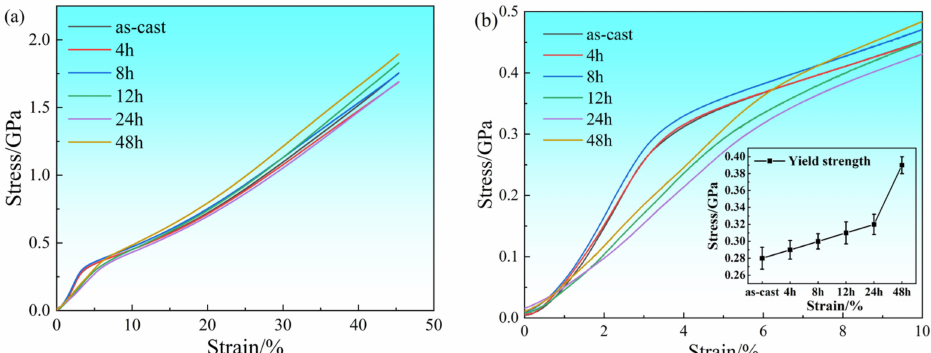
Figure 6. The compressive stress–strain curves of as-cast and cryogenically treated Al 0.6 CrFe 2 Ni 2 HEAs: ( a ) the stress–strain curves with a strain range from 0 to 45%; ( b ) the enlarged stress–strain curves at yield stage. The inset in Figure ( b ) shows the dependence of yield strength on the cryogenic treatment